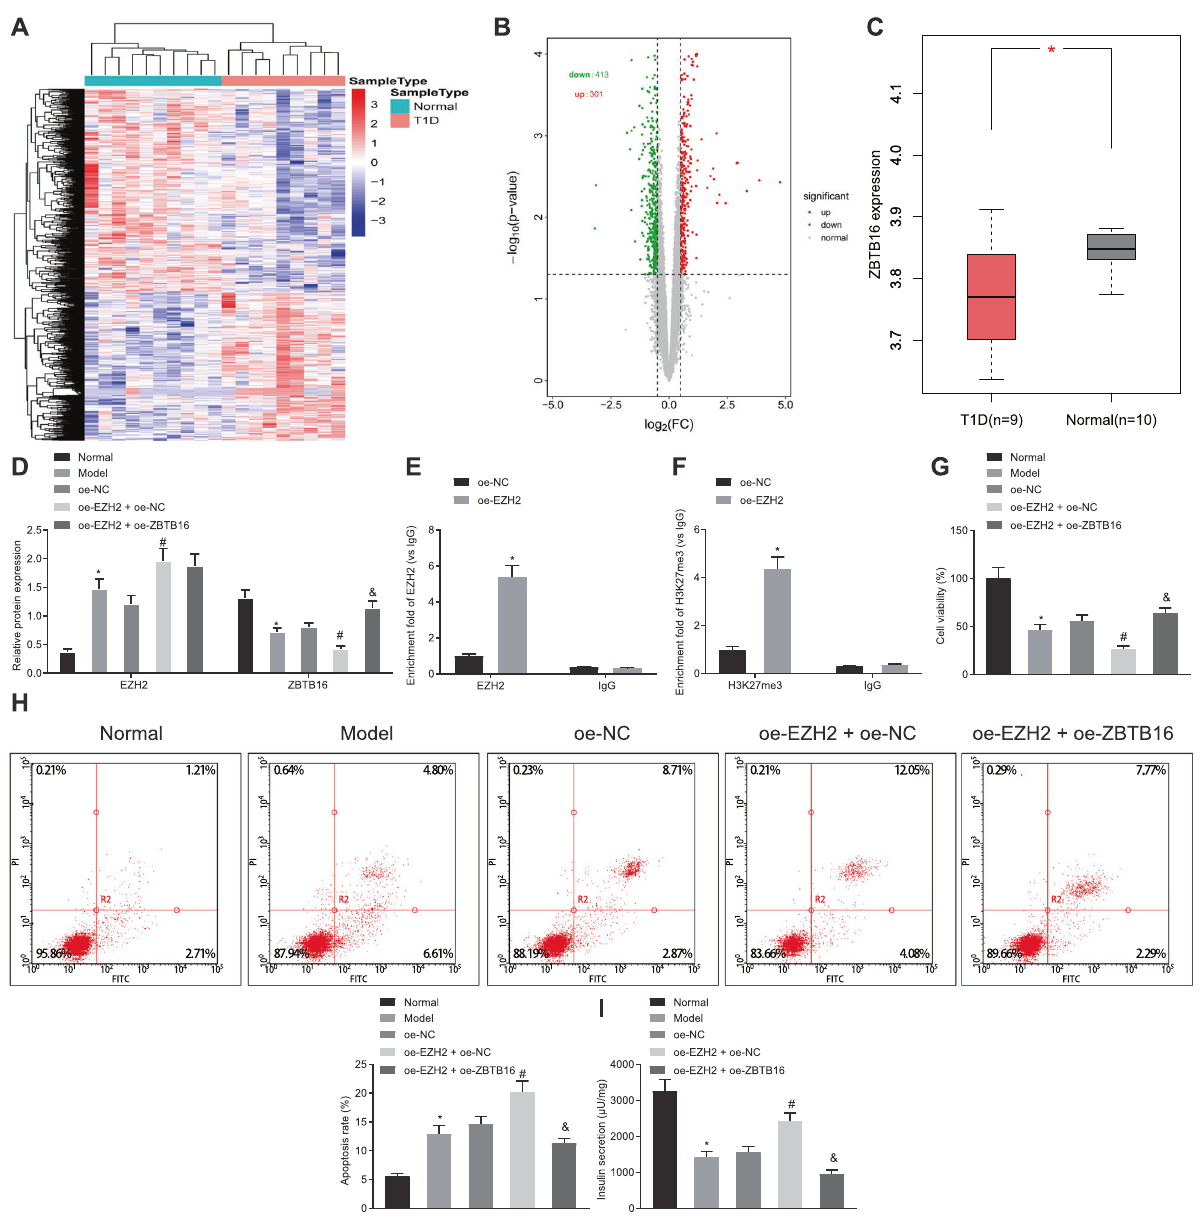
Fig. 4 EZH2 enhances TNF- α -induced pancreatic beta-cell apoptosis and dysfunction through ZBTB16 methylation. A Clustering heat map of differentially expressed genes in a T1D-related dataset, each row represents a gene, and each column represents a sample. B Volcano map of differentially expressed genes in T1D-related dataset, each dot represents a gene, where red dots indicate up-regulation and green dots indicate down-regulation. C The expression of ZBTB16 in the dataset, red indicates T1D samples, gray indicates normal tissue samples. D Western blot assay of the EZH2 and ZBTB16 proteins in the EZH2-, or with ZBTB16-, overexpressed Min6 cells, * p < 0.05 vs. the normal group, # p < 0.05 vs. the OE-EZH2 + OE-NC group, & p < 0.05 vs. the OE-EZH2 + OE-ZBTB16 group. E ChIP assay for detecting EZH2 accumulation in ZBTB16 promoter, * p < 0.05 vs. the OE-NC group. F ChIP assay for detecting H3K27me3 accumulation in ZBTB16 promoter, * p < 0.05 vs. the OE- NC group. G CCK-8 assay for cell variability, * p < 0.05 vs. the normal group, # p < 0.05 vs. the OE-EZH2 + OE-NC group, & p < 0.05 vs. the OE- EZH2 + OE-ZBTB16 group. H Flow cytometry assay for apo p tosis, * p < 0.05 vs. the normal group, # p < 0.05 vs. the OE-EZH2 + OE-NC group, & p < 0.05 vs. the OE-EZH2 + OE-ZBTB16 group. I Determination of insulin secretion, * p < 0.05 vs. the normal group, # p < 0.05 vs. the OE-EZH2 + OE-NC group, & p < 0.05 vs. the OE-EZH2 + OE-ZBTB16 grou p . All experiments were conducted in triplicate. Data comparisons between two groups were analyzed by unpaired t -test. Comparisons among multiple groups were performed by one-way